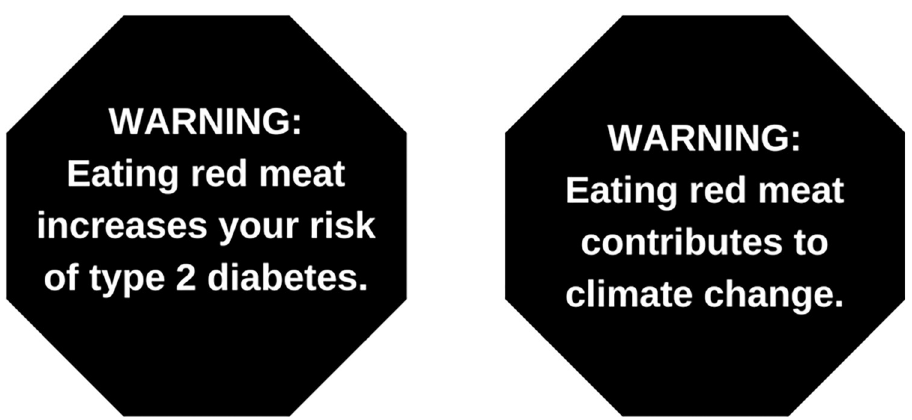
Fig 1. Example of health and environmental warning images tested in online experiment of 1,199 US adults (March 2020).